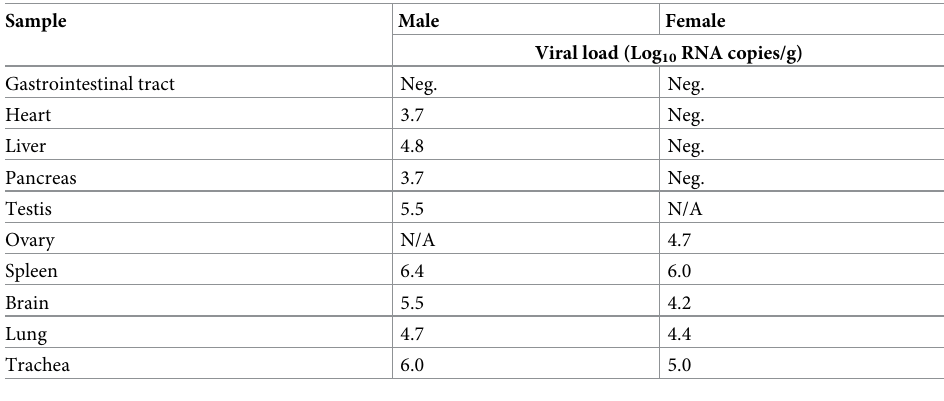
Table 2. Virological testing results of the organ samples of the two necropsied minks from farm B.